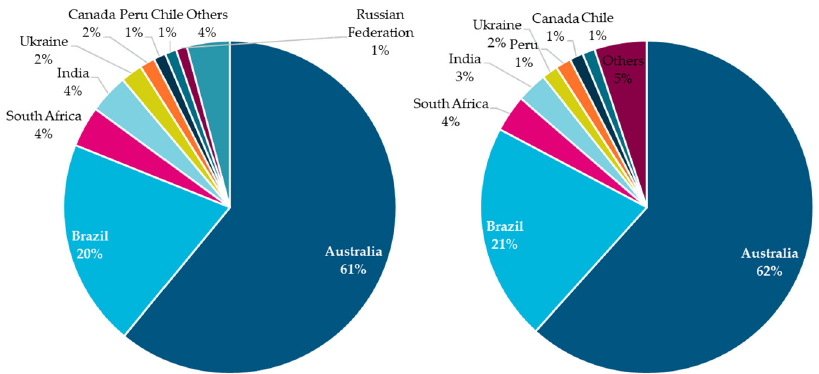
Figure 3. Major trading partners for China ’ s imports of iron ore in 2020 ( left ) and 2021 ( right ). Source: General Administration of Customs, P.R.China.